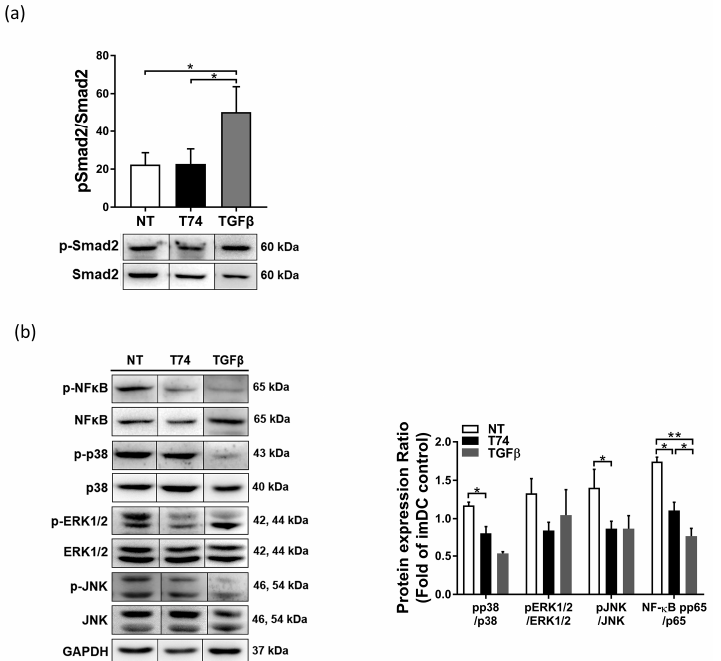
Figure 4. T74 suppresses MAPK and NF κ B signal pathways. ( a ) Western blot analysis of pSmad2, Smad2, and GAPDH. Whole cell lysates prepared from T74-untreated DCs (NT), T74-DCs (T74), and recombinant (rm)TGF- β treated DCs (TGF- β ). ( b ) Western blot analysis of NF- κ Bp65, p38, ERK1/2, and JNK. Phospho-protein expression was normalized to total expression of each respective protein. Fragments of the same image were spliced together to remove irrelevant lanes. Data in panels are representative of three independent experiments. The bar graphs indicate -fold expres- sion (vs. imDCs), presented as the mean ± SEM, n = 3. * p < 0.05, ** p < 0.01.